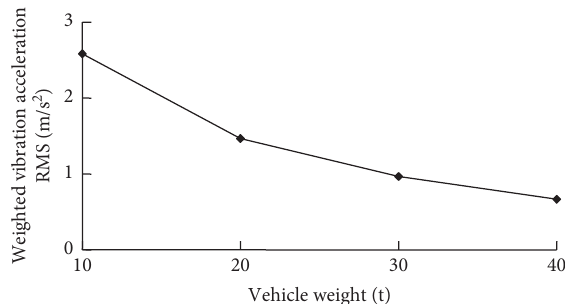
Figure 26: The variation curve of peak values of pitching vibration accelerations of the vehicle body.